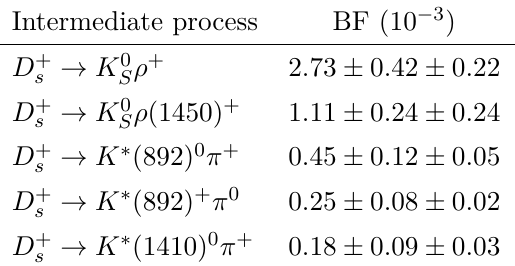
π + π 0 . The first and S